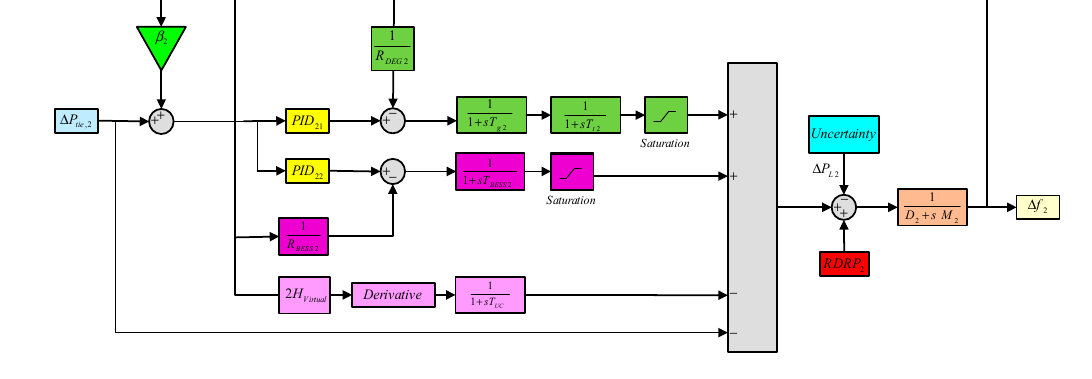
Figure 3. Dynamic model of microgrid 2.